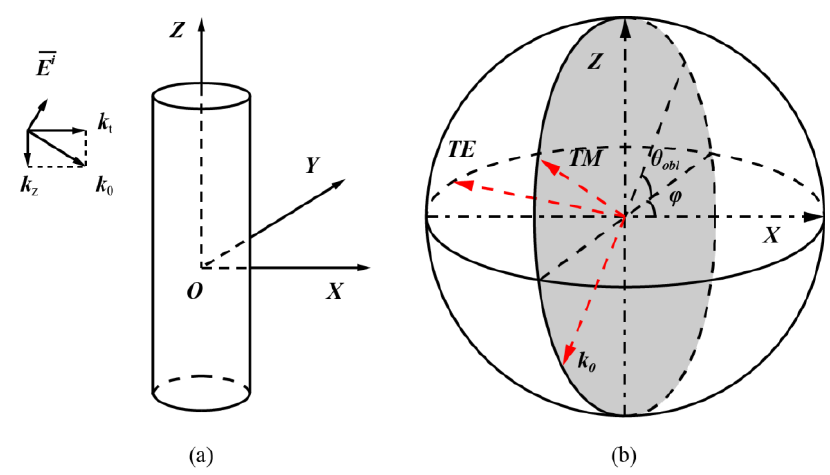
Figure 3. Problem description. ( a ) Analysis model of a two-dimensional object under oblique incidence; and ( b ) coordinate definition. It should be noted that the TM and TE components of the electric field and the wave vector k 0 are orthogonal to each other.